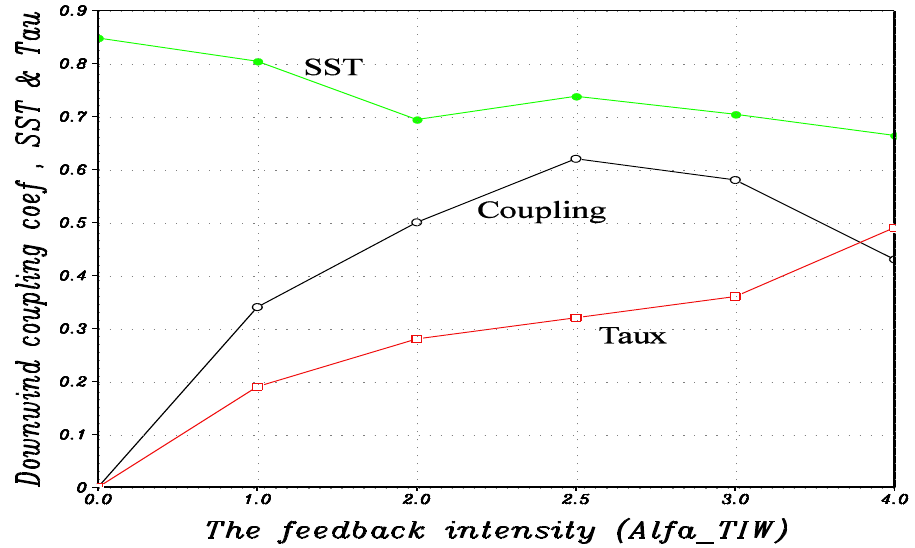
Figure 14. Variations in the TIW coupling coefficient, and the sdv of the zonal τ TIW component and of SST fields, which are expressed as a function of TIW wind feedback TIW intensity (represented by α ). The TIW-scale coupling is represented by the binned slopes TIW between the zonal-high-pass filtered wind stress divergence and the downwind component of the SST gradient, whose computations are made using daily data over the region (0°N–5°N, 150°W–105°W) during the cold season (August–December) in year 13. The unit is N·m −2 per 10 4 km for the coupling coefficient; to use the same y-axis for indicating the units of τ and of SST , the sdv values for τ and of SST plotted in the figure are TIW TIW TIW TIW multiplied respectively by 10 and 2,